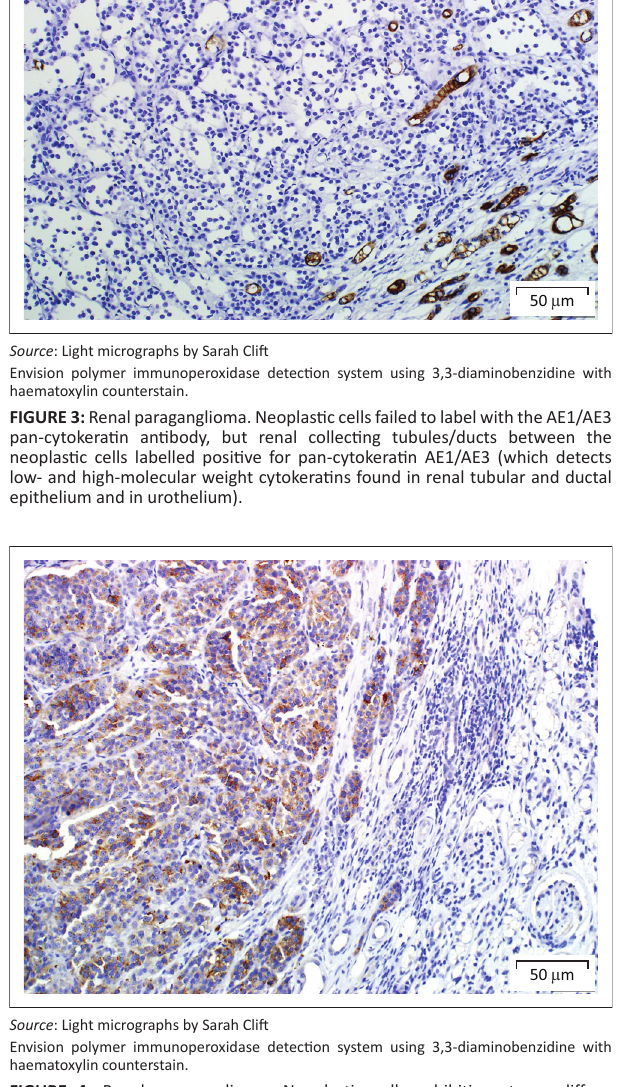
haematoxylin counterstain. FIGURE 6: Renal paraganglioma. Rare sustentacular cells labelled in a typical nuclear and cytoplasmic pattern with the S100 antibody for calcium-binding proteins; S100 is highly specific for sustentacular cells within the normal or tumourous adrenal medulla, extra-adrenal paraganglia and autonomic